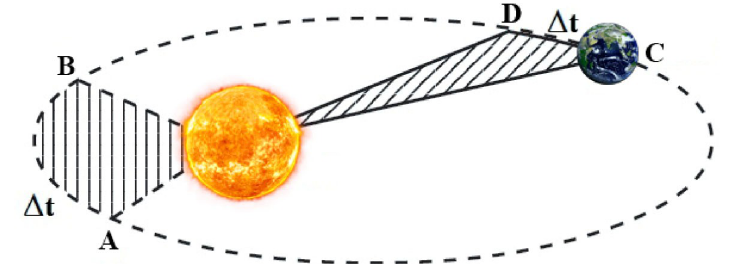
Figure 10. All landscaped areas have the same area values at the same